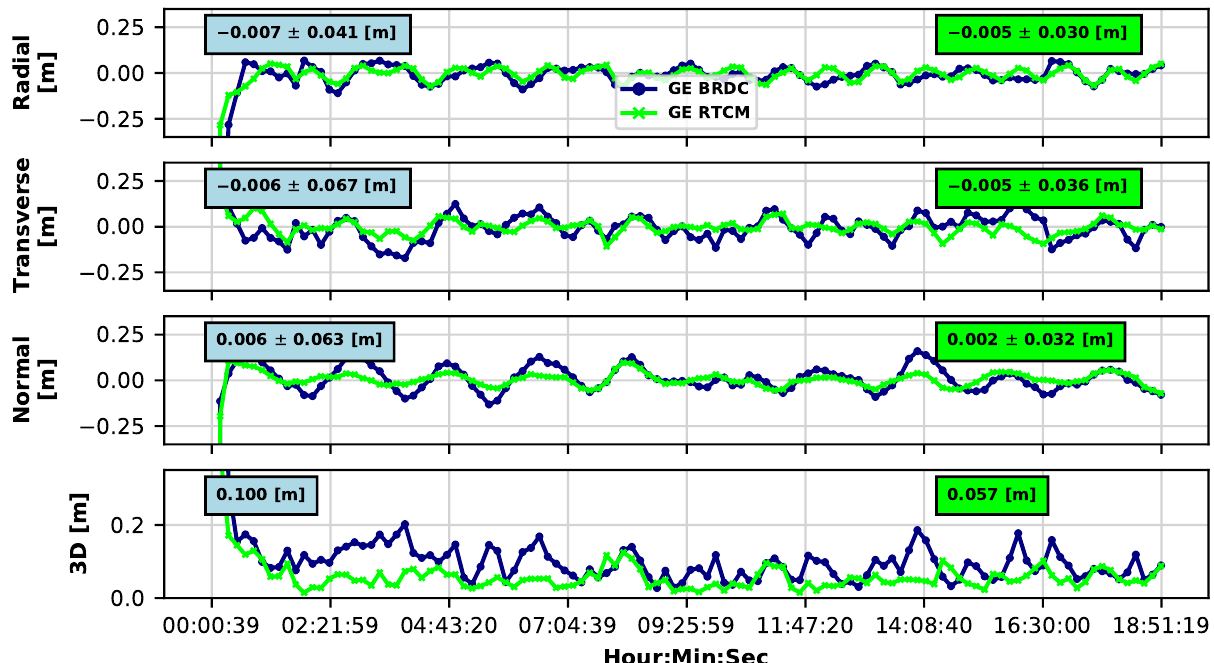
Figure 1. S6A orbital position difference with respect to CNES-POD reference solution on 4 September 2021. Two solutions are compared: the first is obtained by using only broadcast navigation data (blue-colored lines), and the second is found by correcting the broadcast navigation data using RTCM corrections from CNES (green-colored lines). For the individual axes (RTN frame), the mean values standard deviation of the differences are provided (light-blue-filled boxes for BRDC and ± light-green-filled boxes for RTCM). The RMS value is shown for the 3D